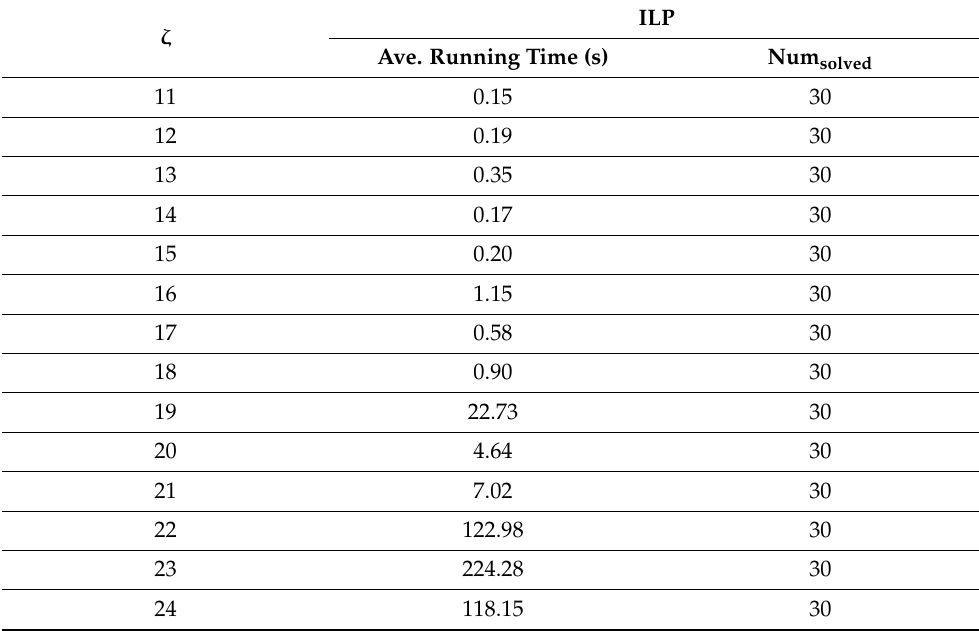
Table 1. Experimental results for cases with ζ ∈ [11, 24].